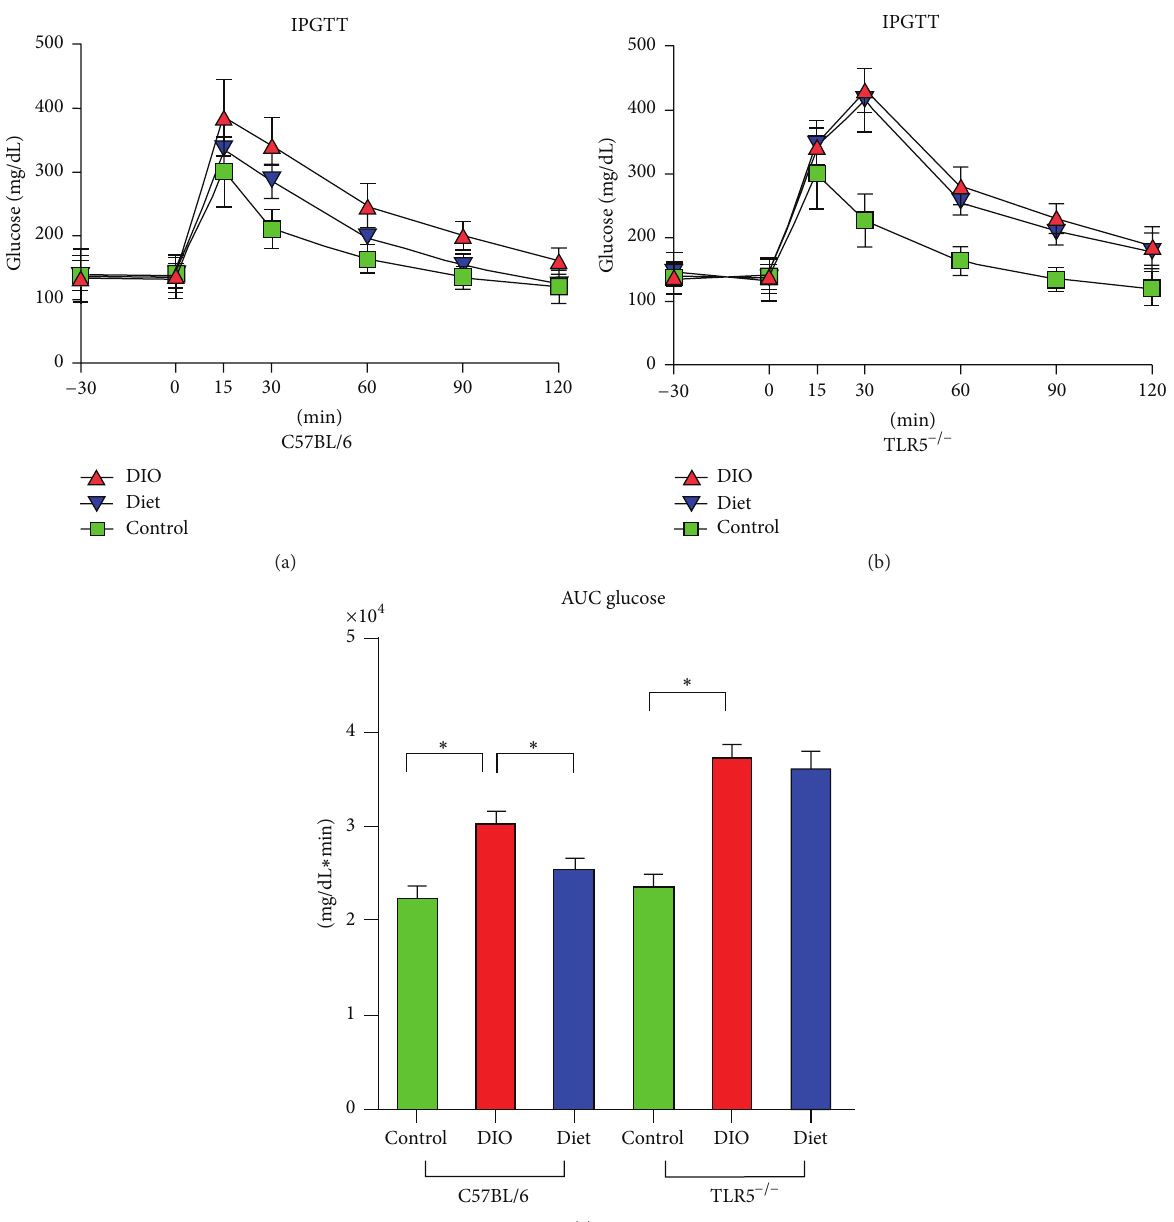
Figure 2: Intraperitoneal blood glucose concentrations of (a) C57BL/6 and (b) TLR5 −/− mice and (c) the quantification of area under the curve (AUC) during a 120 min intraperitoneal glucose tolerance test (IPGTT) in groups of control, DIO, and diet at week 12. ∗ 𝑝 <